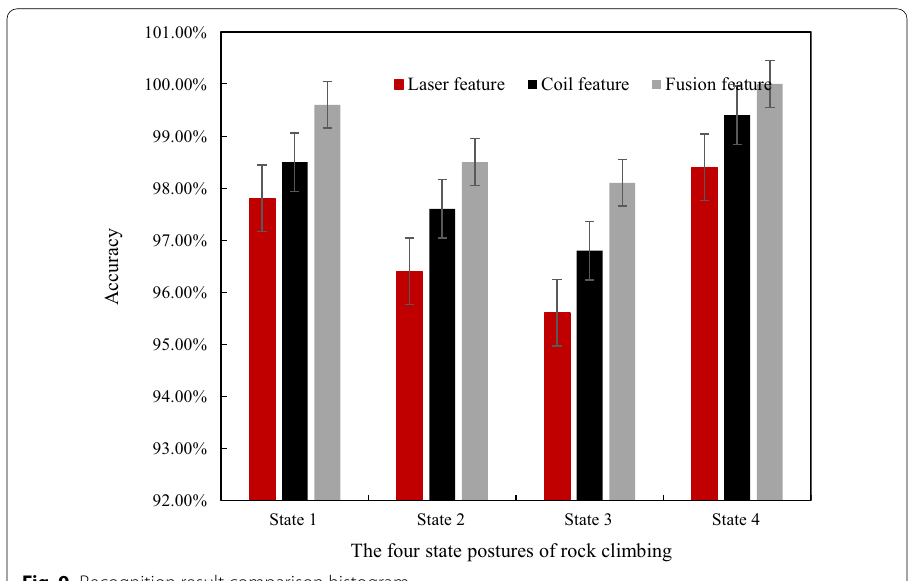
Fig. 9 Recognition result comparison